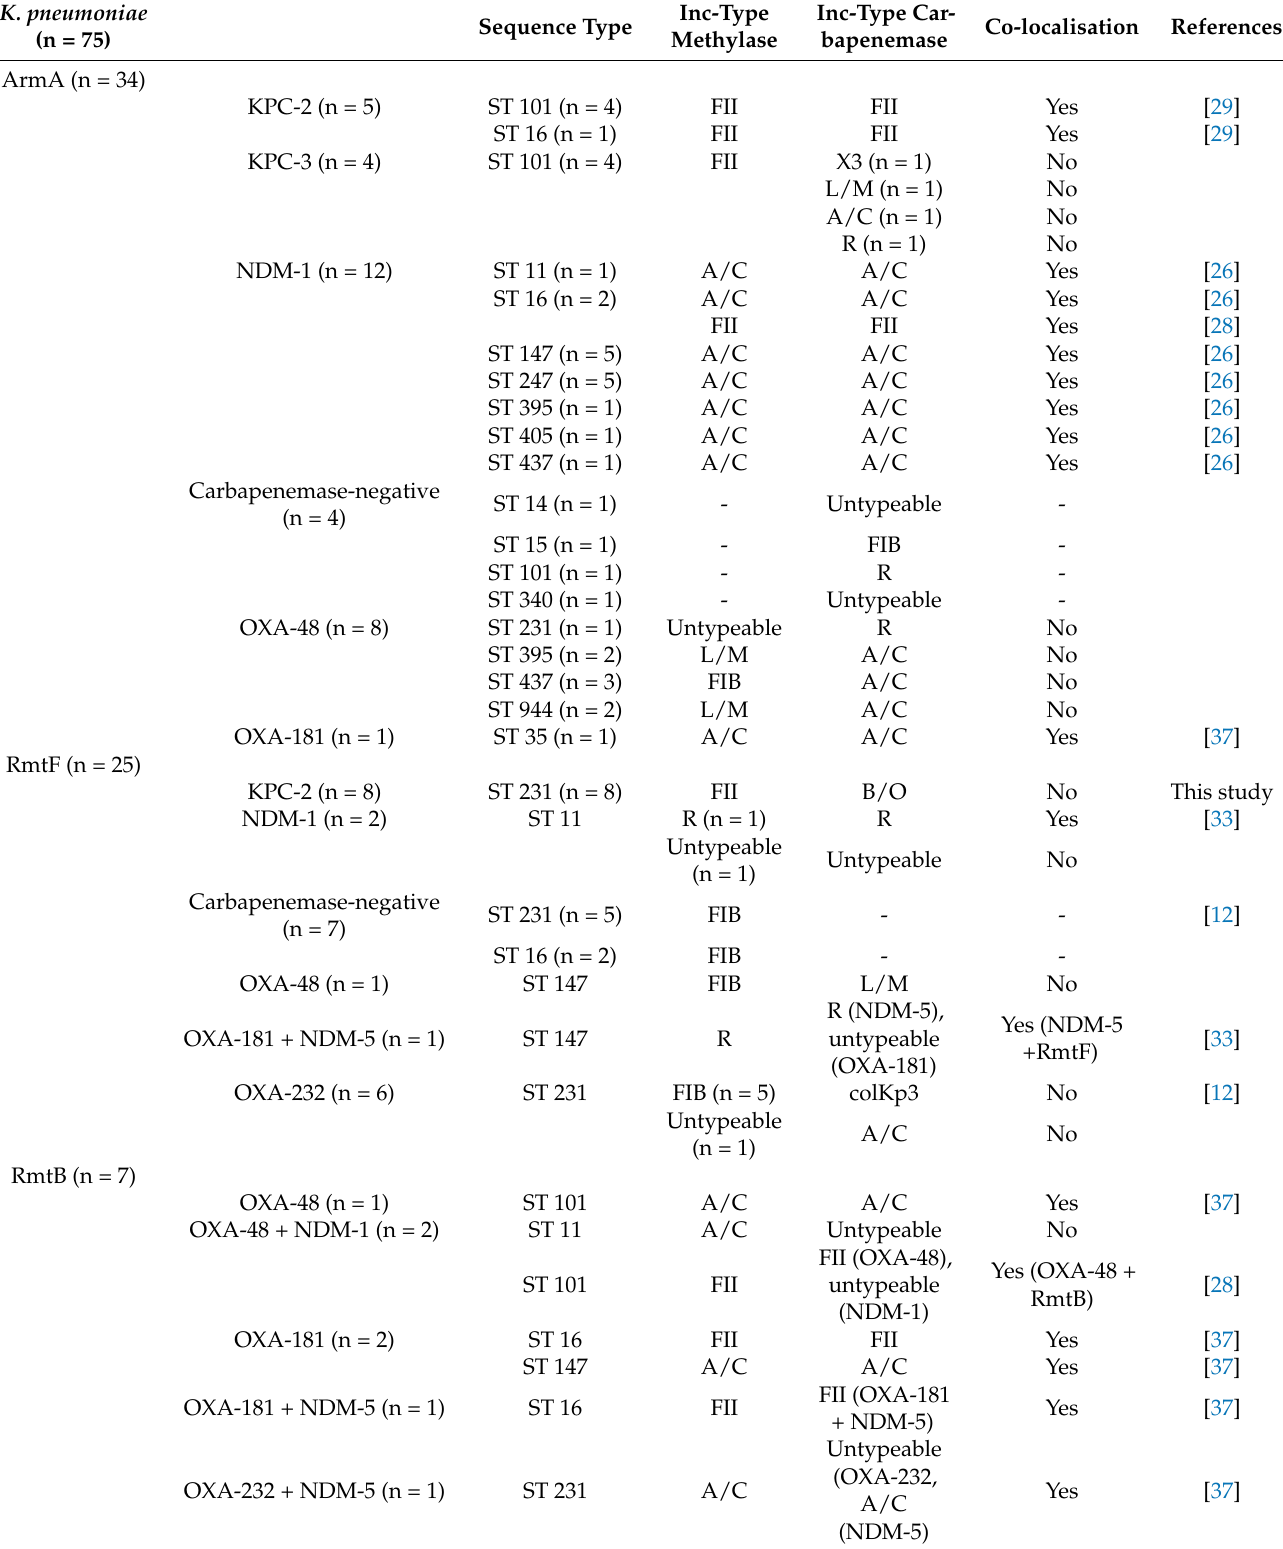
Table 3. Association of 16S RMTases, carbapenemases, sequence types, and plasmid incompatibility groups among pan-aminoglycoside- and carbapenem-resistant K. pneumoniae